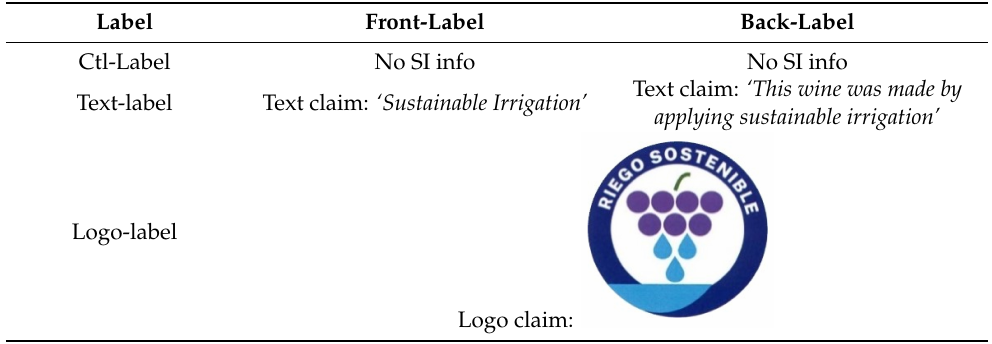
Table 1. Factors evaluated and the nomenclature used in this study. SI: sustainable irrigation. Translation of “Riego Sostenible” included on the logo is “Sustainable irrigation”